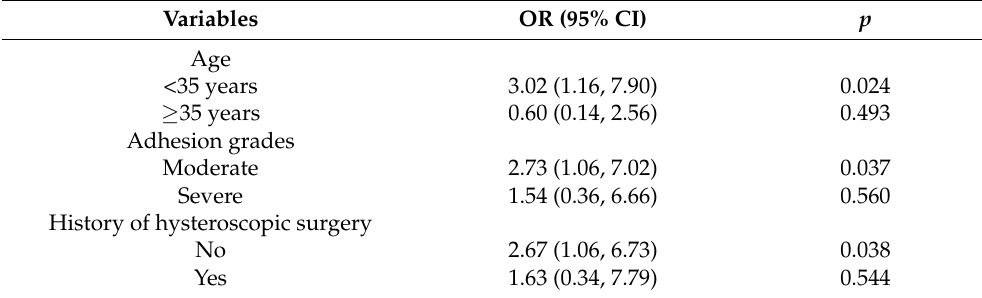
Table 5. The results of stratified